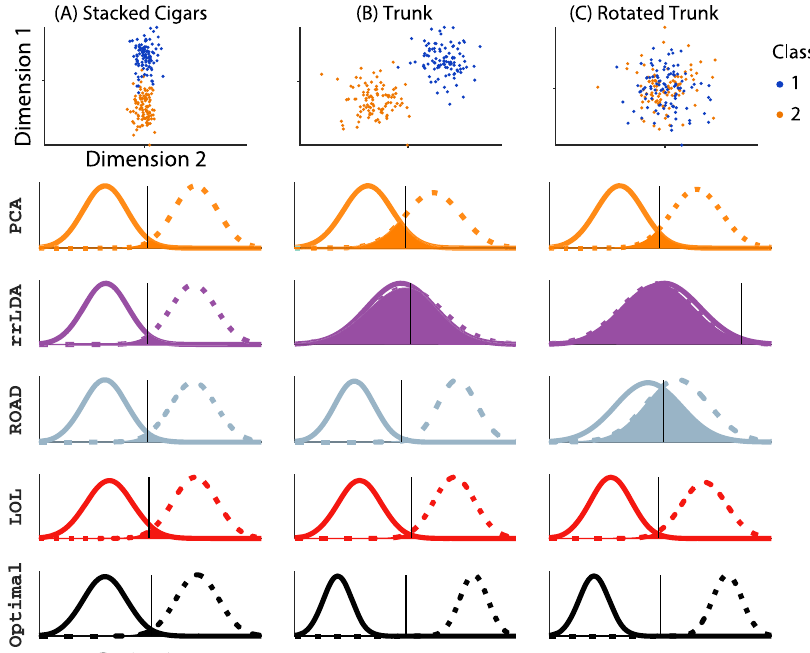
Fig. 5 LOL achieves near-optimal performance for three different multivariate Gaussian distributions, each with 100 samples in 1000 dimensions. For each approach, we project into the top three dimensions, and then use LDA to classify 10,000 new samples. The six rows show (from top to bottom): Row 1: A scatter plot of the fi rst two dimensions of the sampled points, with class 0 and 1 as orange and blue dots, respectively. The next rows each show the estimated posterior for class 0 and class 1, in solid and dashed lines, respectively. The overlap of the distributions---which quanti fi es the magnitude of the error---is fi lled. The black vertical line shows the estimated threshold for each method. The techniques include: PCA ; reduced rank LDA ( rrLDA ), a method that projects onto the top d eigenvectors of sample class-conditional covariance; ROAD , a sparse method designed speci fi cally for this model; LOL , our proposed method; and the Bayes optimal classi fi er. A Stacked Cigars The mean difference vector is aligned with the direction of maximal variance, and is mostly concentrated in a single dimension, making it ideal for PCA , rrLDA , and sparse methods. In this setting, the results are similar for all methods, and essentially optimal. B Trunk The mean difference vector is orthogonal to the direction of maximal variance; PCA performs worse and rrLDA is at chance, but sparse methods and LOL can still recover the correct dimensions, achieving nearly optimal performance. C Rotated Trunk Same as ( B ), but the data are rotated; in this case, only LOL performs well. Note that LOL is closest to Bayes optimal in all three